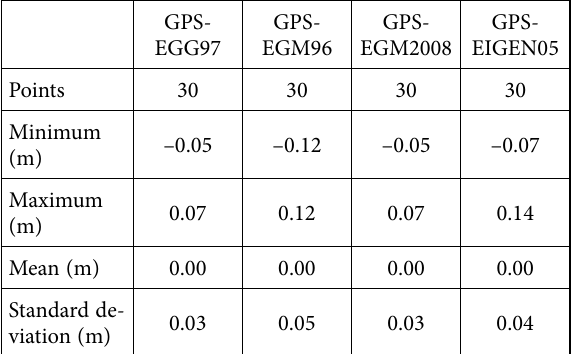
Table 1. Geoid height residuals to GPS/Leveling points